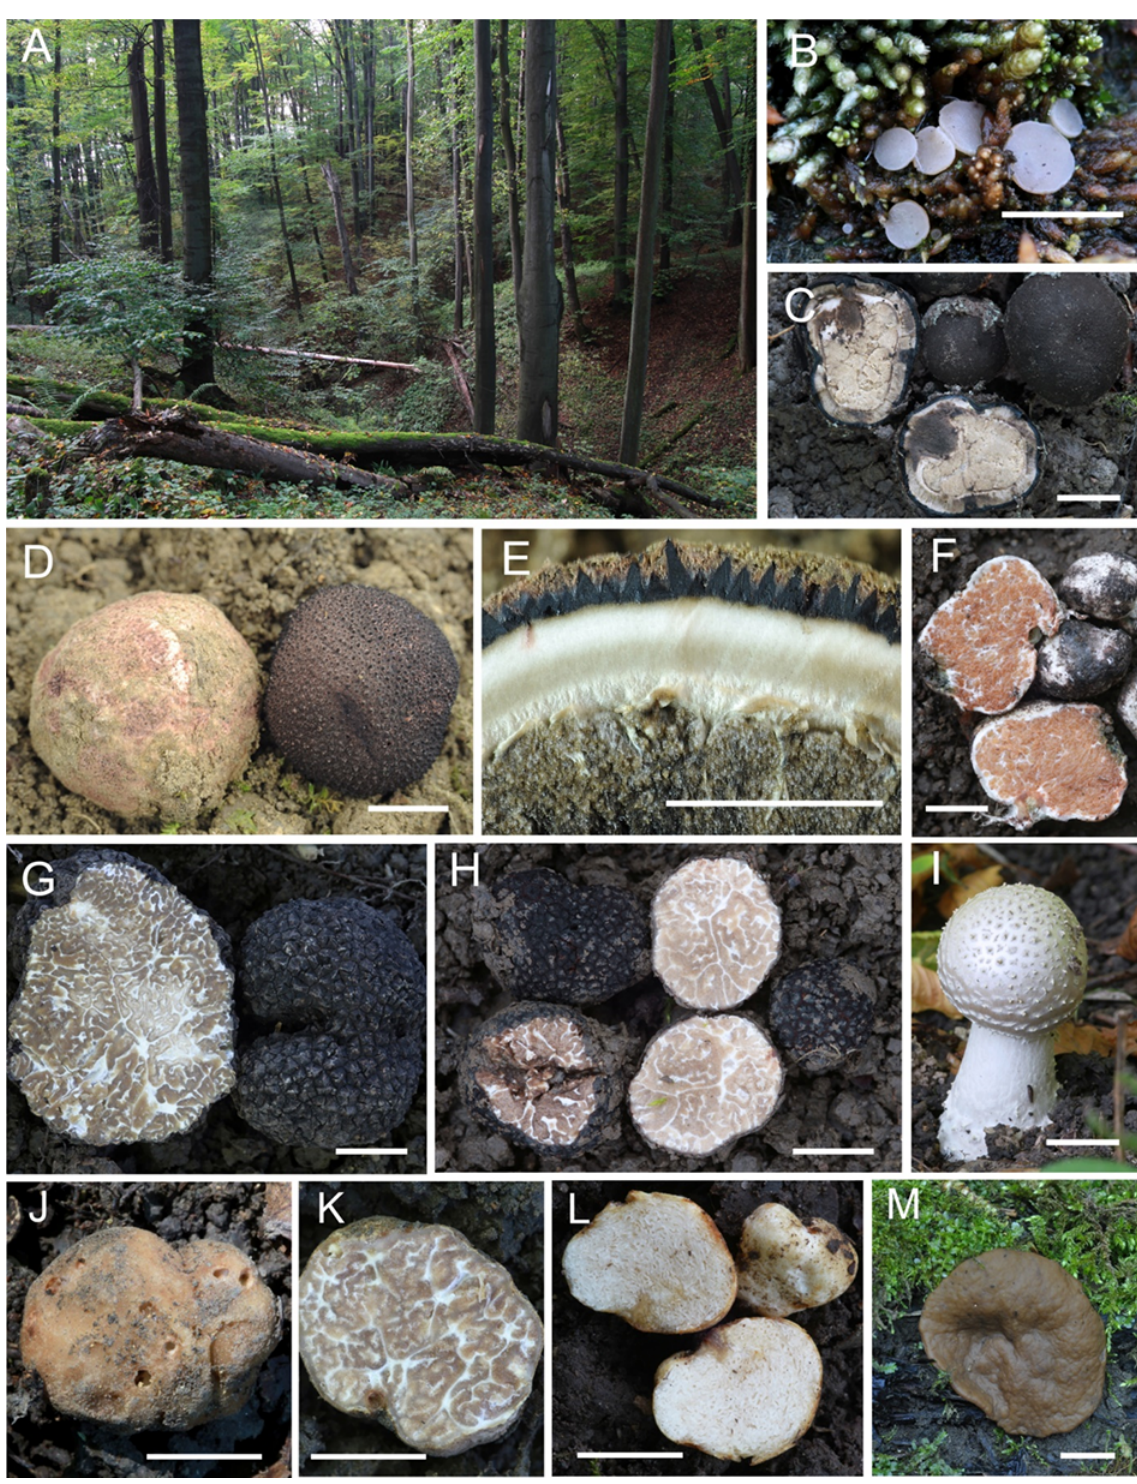
Figure 2 Selected fungi species found in the Cieszyn area. ( A ) Characteristic type of forest community for the Silesian Foothills – calcareous beech forest in the “Kopce” nature reserve. ( B ) Group of Bryoscyphus dicrani ascomata on Bryum argenteum sporophytes. ( C ) Ascomata of Elaphomyces maculatus from the outside and in section. ( D ) Ascomata of E. aculeatus – with pink crust on the left side, without crust with black and pink peridium on the right side. ( E ) Elaphomyces aculeatus , cross section through the ascoma, with black acute warts within the peridium. ( F ) Basidiomata of Octaviania lutea in section. ( G ) Ascomata of Tuber aestivum from the outside and in section. ( H ) Ascomata of T. brumale from the outside and in section. ( I ) Young basidioma of Amanita echinocephala . ( J,K ) Tuber foetidum , surface ( J ) and cross section of the basidioma ( K ). ( L ) Basidiomata of Russula cerea from the outside and in section. ( M ) Ascoma of Discina martinii . Scale bars: ( B–M ) 10 mm. Photographs by M. Fiedor ( A–C,F–L ) and R. Rutkowski ( D,E,M